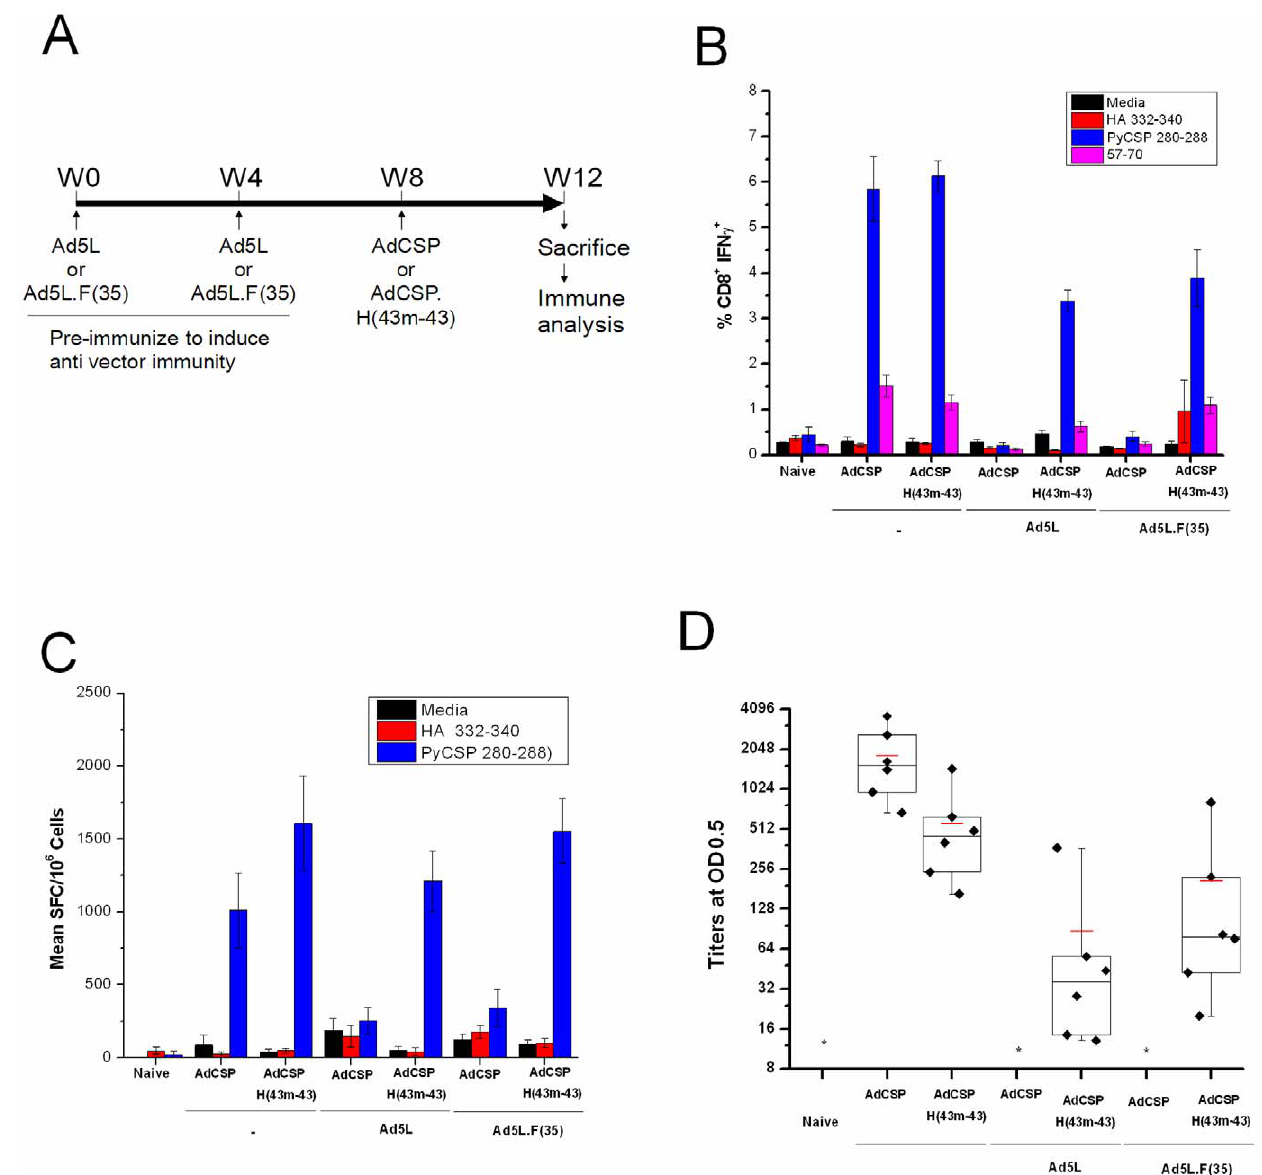
Figure 5. Ad5 Py CSP.H(43 m-43) induces T cells responses similar to Ad5 Py CSP in naı¨ve mice and is not inhibited by Ad5 NAb in vivo . Naı¨ve BALB/c mice or mice pre-immunized with two injections (1 6 10 10 pu each) of Ad5 vector or an Ad5 vector containing the Ad35 fiber, were immunized with Ad5 Py CSP, or hexon-modified vector Ad5PyCSP.H(43 m-43) (n=6 mice/group). Py CSP-specific T cell responses were assessed by Intracellular cytokine staining (ICS) and IFN c ELISpot four weeks after immunization. Targets were MHC-matched A20.2J cells pulsed with synthetic peptides representing the immunodominant CD8 + T cell epitope (PyCSP280–288) or CD4 + T cell epitope with nested subdominant CD8 + T cell epitope ( Py CSP57–70) from Py CSP or a defined CD8 + T cell epitope for the influenza virus hemagglutinin antigen (HA 332–340). (A) Schematic of the experiment. (B) ICS analysis of CD8 + IFN c + T cell responses from immunized mice assayed individually. Error bars indicate the standard error of the mean, n=6. (C) IFN c ELISpot responses from pooled splenocytes (250,000 cells/well). Error bars indicate the standard deviation of the mean from quadruplicate samples. (D) ELISA against recombinant Py CSP protein capture antigen. Box-and-whisker plot with values for individual mice shown (n=6). The mean is indicated by the red line. * indicates groups where titers from all mice were , 8. doi:10.1371/journal.pone.0033920.g005 Py CSP280–296) (Figure 6b). The heterologous adenovector Ad35/Ad5 titers were comparable and all three superior to Ad5/ prime/boost regimens induced Py CSP antibody titers comparable to DNA/Ad5- Py CSP and higher titers than Ad5/Ad5- Py CSP and Ad5/Ad5, Py CSP-specific titers were enhanced . 30 fold by the Ad5- Py CSP alone regimens (Figure 6c). Protective regimens (p , 0.05) induced higher Py CSP-specific antibody titers ( . 4500 titer at OD 0.5) 10 days post-boost as compared with the non- ICS analysis confirmed that Py CSP-specific CD3 + CD8 + cells protective regimens. DNA/Ad5, Ad5.H43/Ad5, Ad28/Ad5, and were the primary responders, with minimal Py CSP-specific